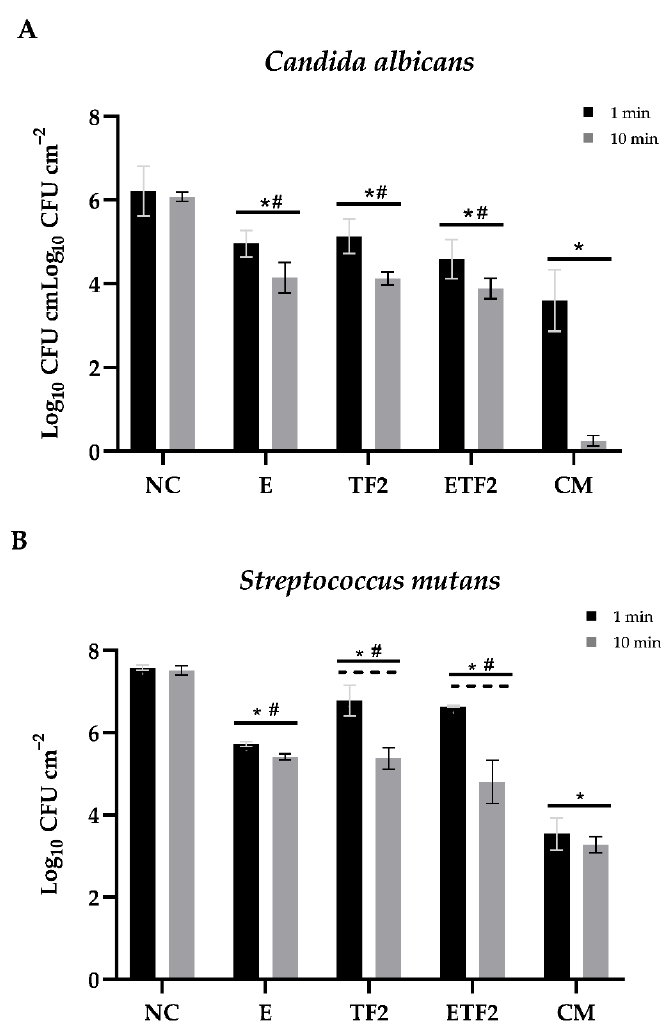
Figure 2. NC: negative control; E: formulation with 3% pomegranate peel extract; TF2: formulation with 0.3% sodium-trimetaphosphate + 225 ppm of fluoride; ETF2: formulation with 3% pomegranate peel extract + 0.3% sodium-trimetaphosphate + 225 ppm of fluoride; CM: essential oil commercial mouthwash. Means and standard deviations of viable (Log 10 cm 2 ) Candida albicans ATCC 10231 ( A ) and Streptococcus mutans ATCC 25175 cells ( B ), and biofilms after treatment with each formulation for 1 min and 10 min. ( A ): Asterisk indicates p < 0.05 versus negative NC; # indicates p < 0.05 of ETF2 (after 1 min), TF2 (after 1 min), and E (after 1 min) versus CM (after 1 min) (one-way ANOVA followed by Holm–Sidak test). ( B ): Asterisk indicates p < 0.05 versus NC; # indicates p < 0.05 of ETF2, TF2, and E versus CM; —- indicates p < 0.05 of ETF2 (after 1 min) versus ETF2 (after 10 min), and TF2 (after 1 min) versus TF2 (after 10 min) (one-way ANOVA followed Holm–Sidak post hoc